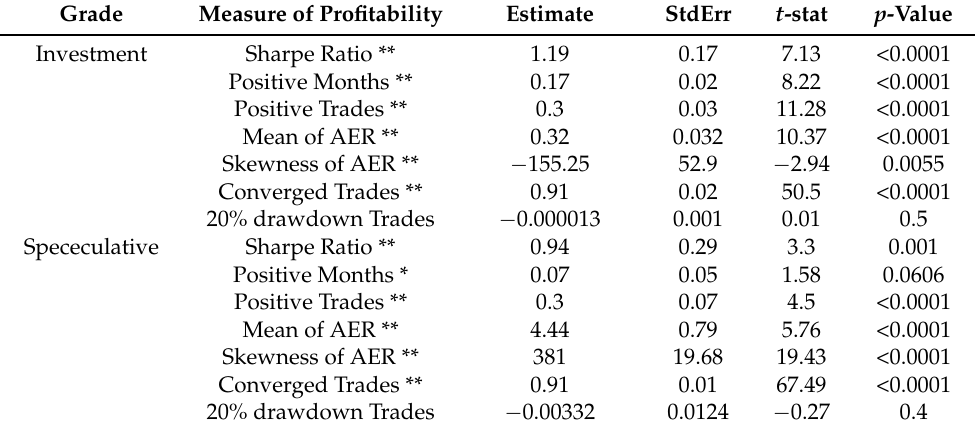
Table 3. TS1 vs. Yu